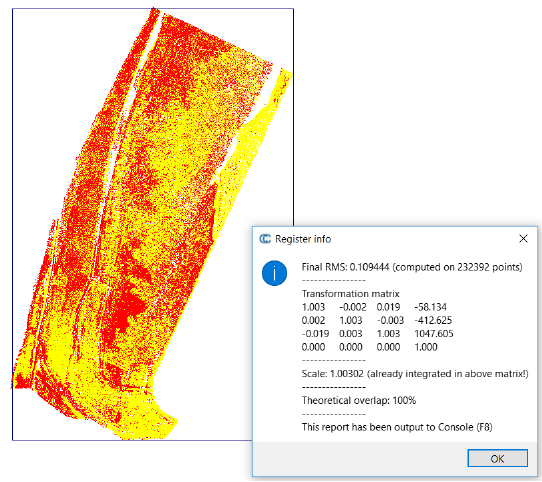
Figure 16. ICP registration result